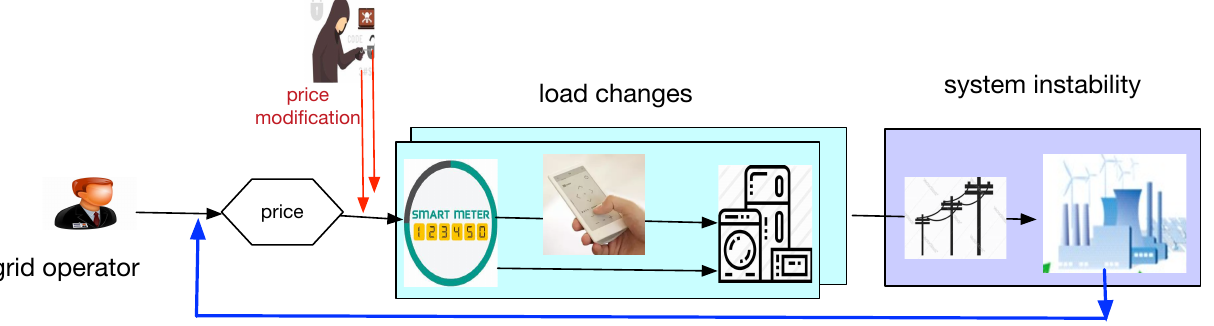
Figure 3. Price modification and system